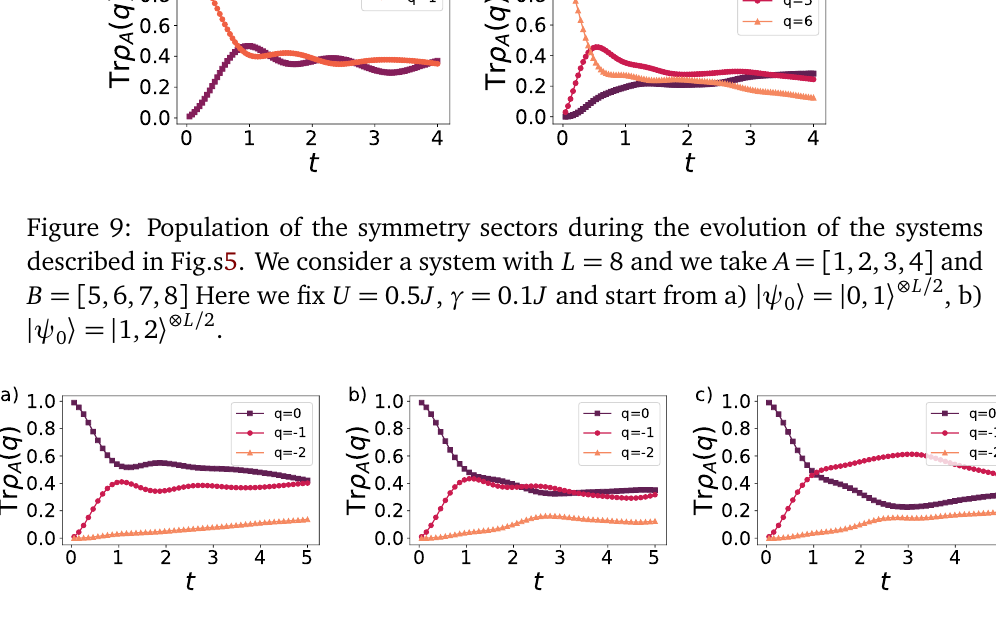
⊗ N / 2 . We consider a system with L = 12 = 0; c) w = 1 m = 0, J = 1, ε = 0.5. 0 0